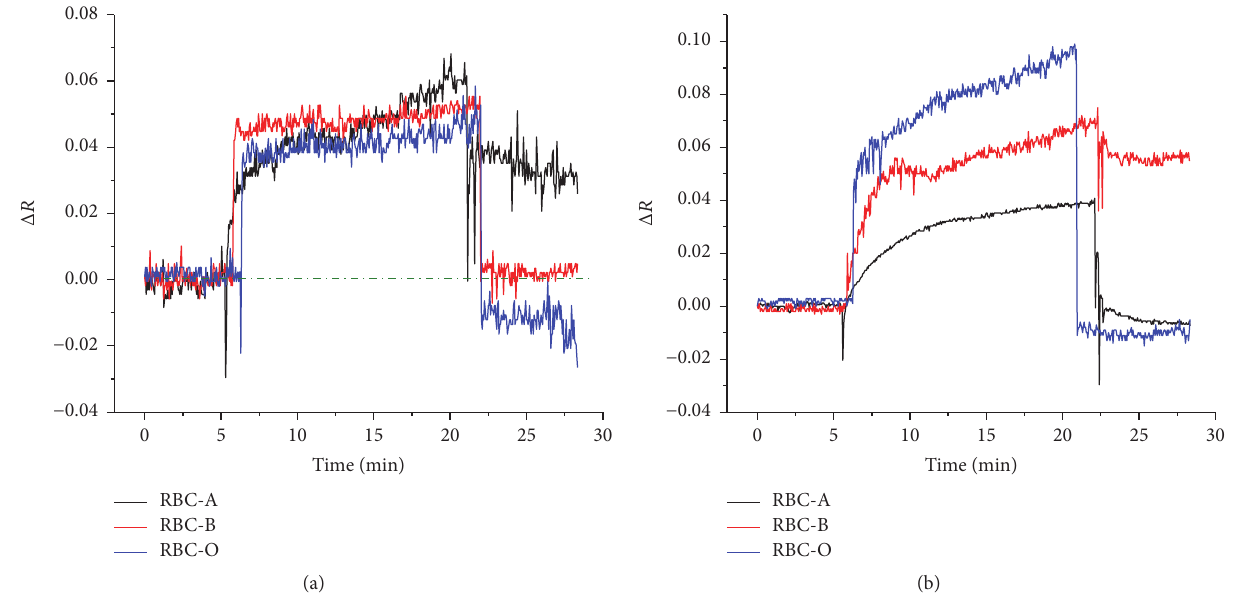
Figure 7: LR-SPR kinetic curves during the detection of RBC-A, RBC-B, and RBC-O on Anti-A (a) and on Anti-B (b).